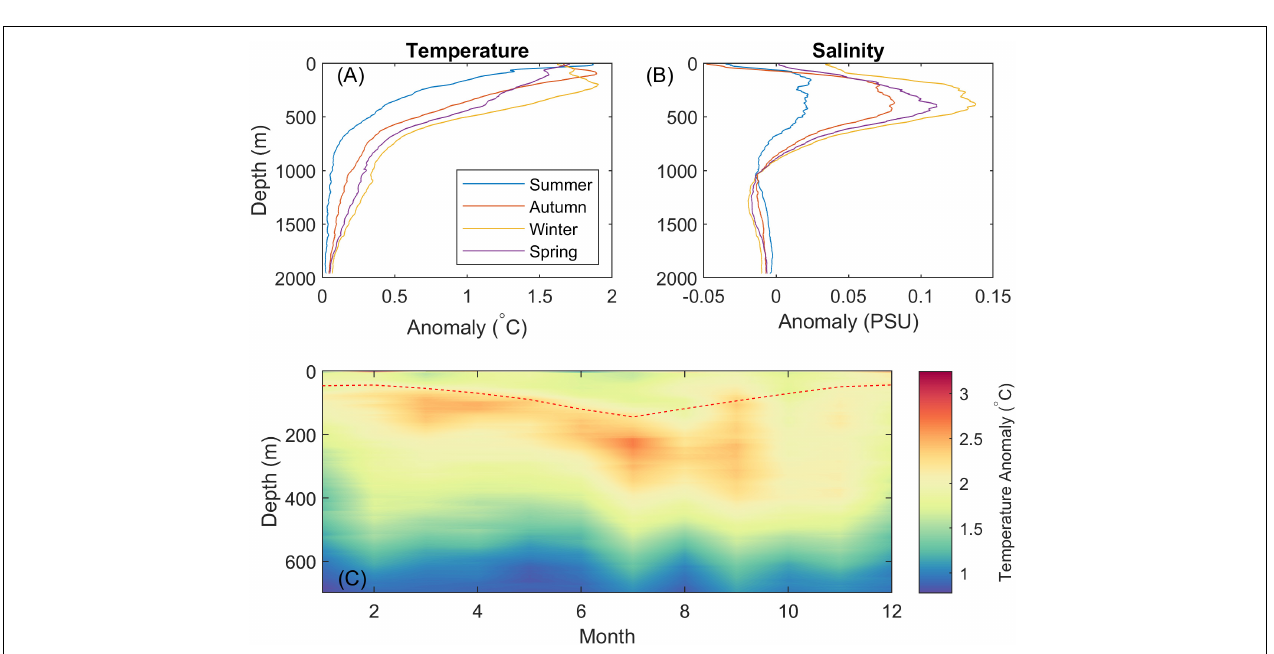
FIGURE 8 | Latitudinal (A) and monthly (B) distribution of Argo float profiles during MHWs for shallow (category 1), intermediate (category 2) and deep (category 3) events.